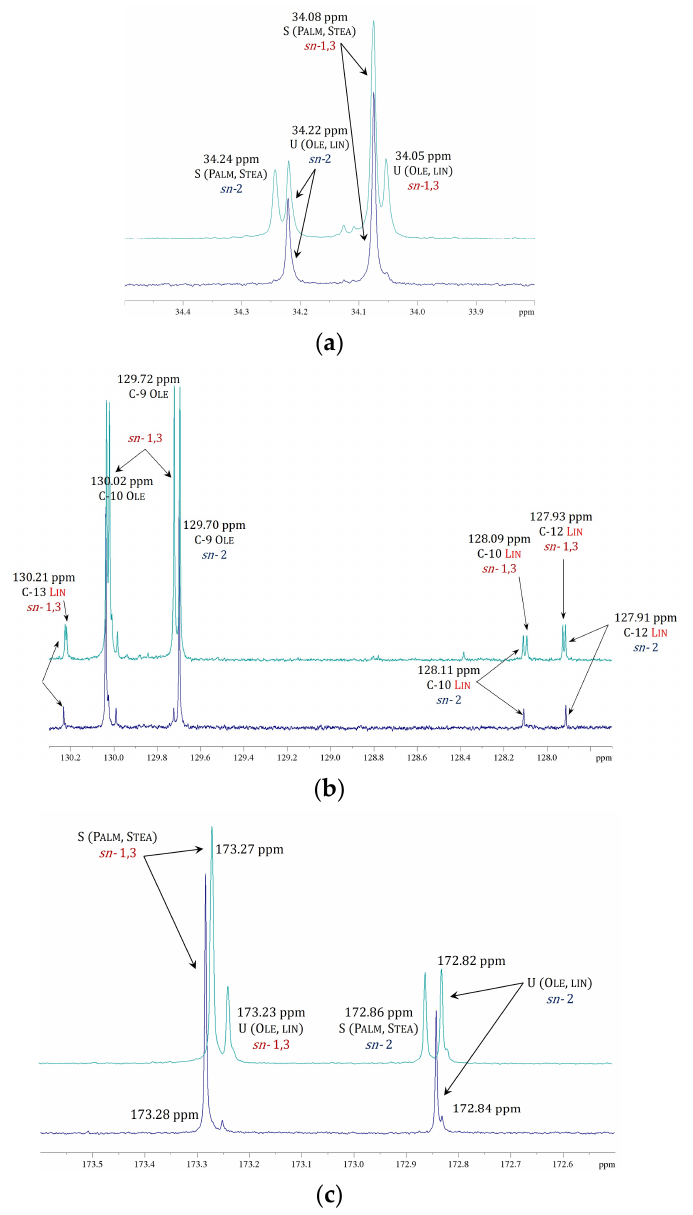
Figure 11. Comparison of 13 C NMR spectra (125 MHz, 298 K, in CDCl 3 ) for natural CB (sample A, in blue) and modified butter (sample B, green) in the range of ( a ) the α -carbons signals C-2 [33.80–34.50 ppm], ( b ) olefinic signals of mono-unsaturated and di-unsaturated acyl chains [127.70–130.30 ppm] and ( c ) of the carbonylic carbon signals of mono-unsaturated and saturated fatty acids [172.50–173.60